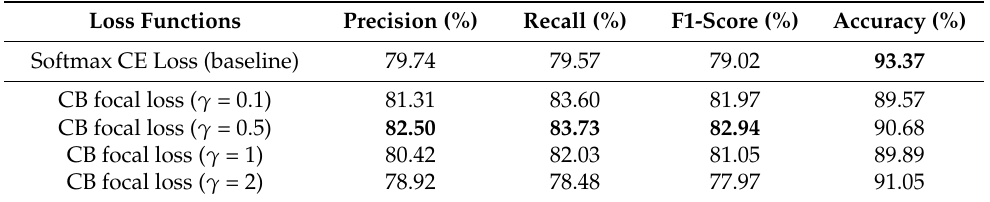
Table 3. Performance comparison between softmax CE loss and CB focal loss with different γ . The best results for each metric are highlighted in bold.